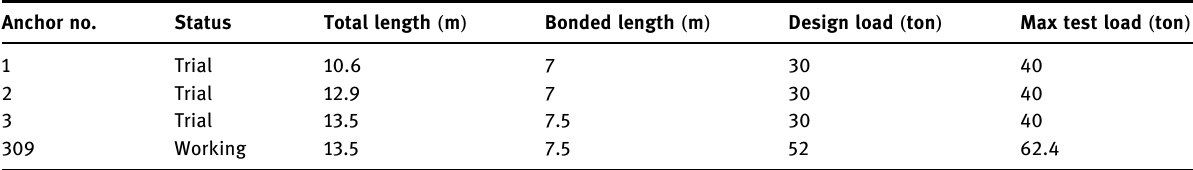
Table 1: Total length and bonded length of grouted anchors Anchor no.